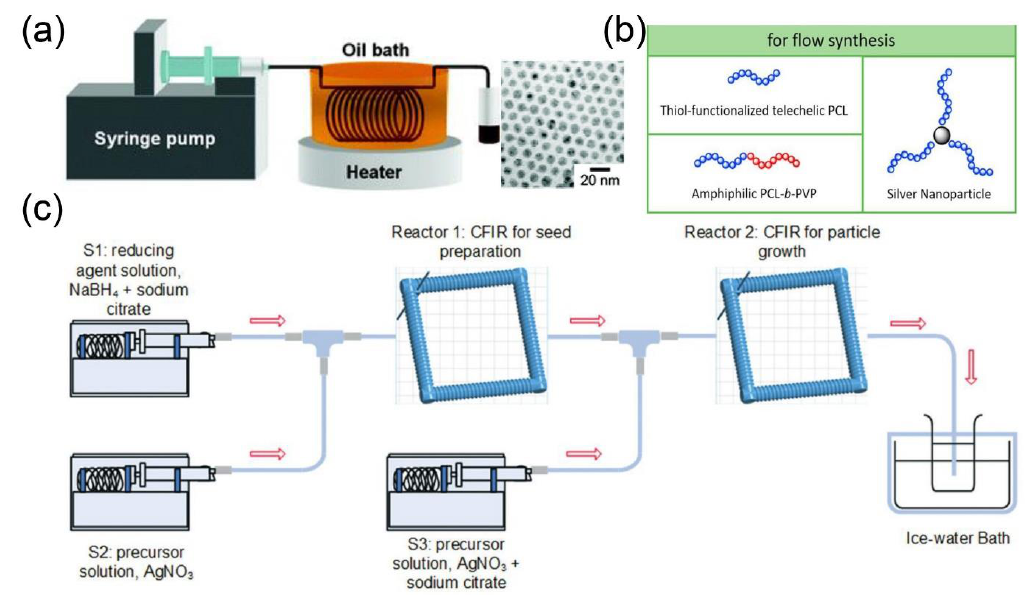
Figure 5. ( a ) Experimental setup for the synthesis of silver nanoparticles in a tubular-shaped